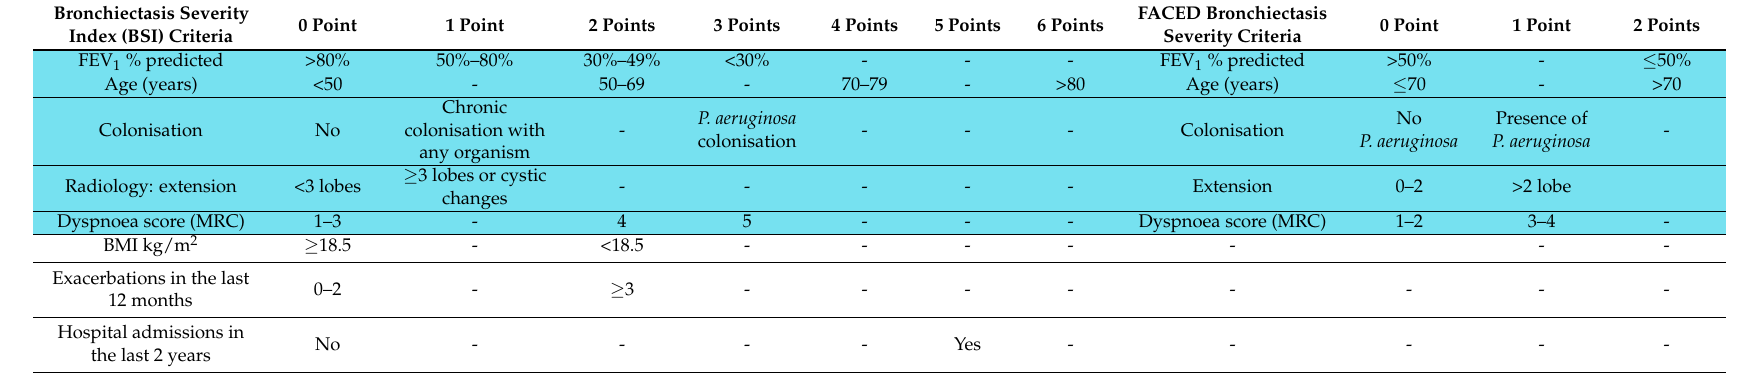
Table 1. Comparing the Bronchiectasis Severity Index (BSI) and FACED severity scores in bronchiectasis. Data adapted from the EMBARC registry, www.bronchiectasis.eu, ref. [34]. FEV 1 : Forced expiratory volume in 1 s; MRC: Medical Research Council; BMI: Body Mass